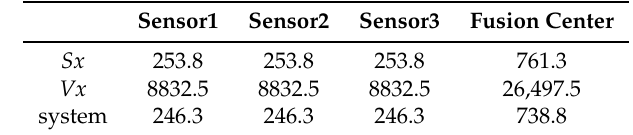
Table 1. Observable degree of local filter and fusion center with condition that fusion system consists of the same kind of sensors.